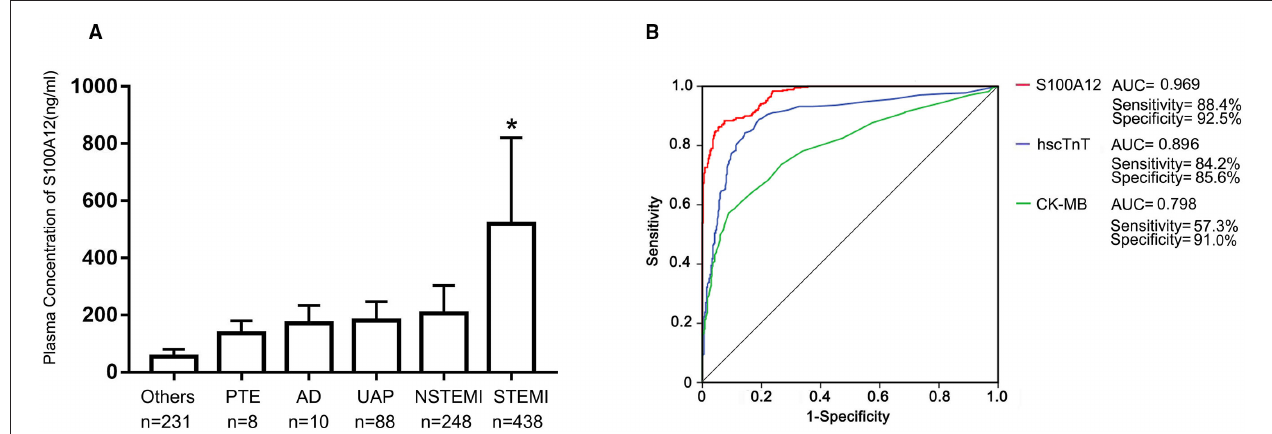
FIGURE 1 | Plasma S100A12 levels and diagnostic accuracy. Baseline plasma S100A12 concentrations at the time of hospital arrival to the emergency department were measured by ELISA in the diagnosis cohort. (A) Bars and limit lines represent the mean ± SD. UAP, unstable angina pectoris; PTE, pulmonary thromboembolism;